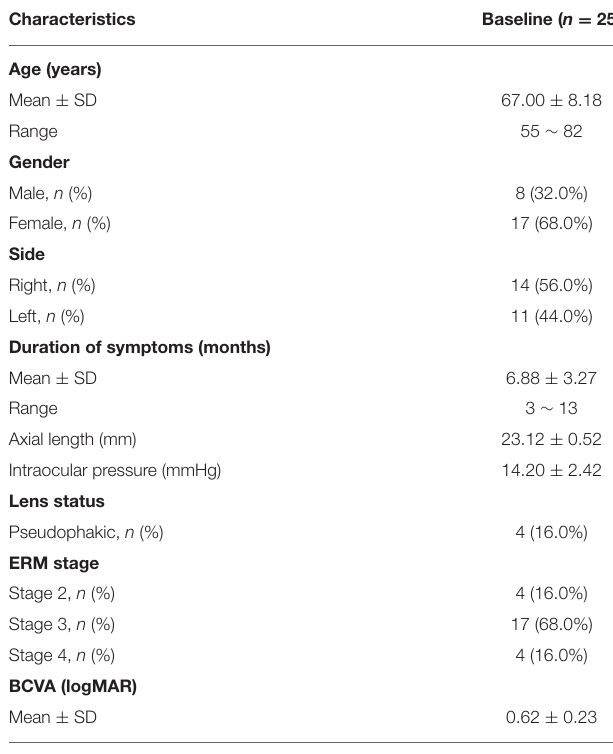
TABLE 1 | Baseline characteristics of study